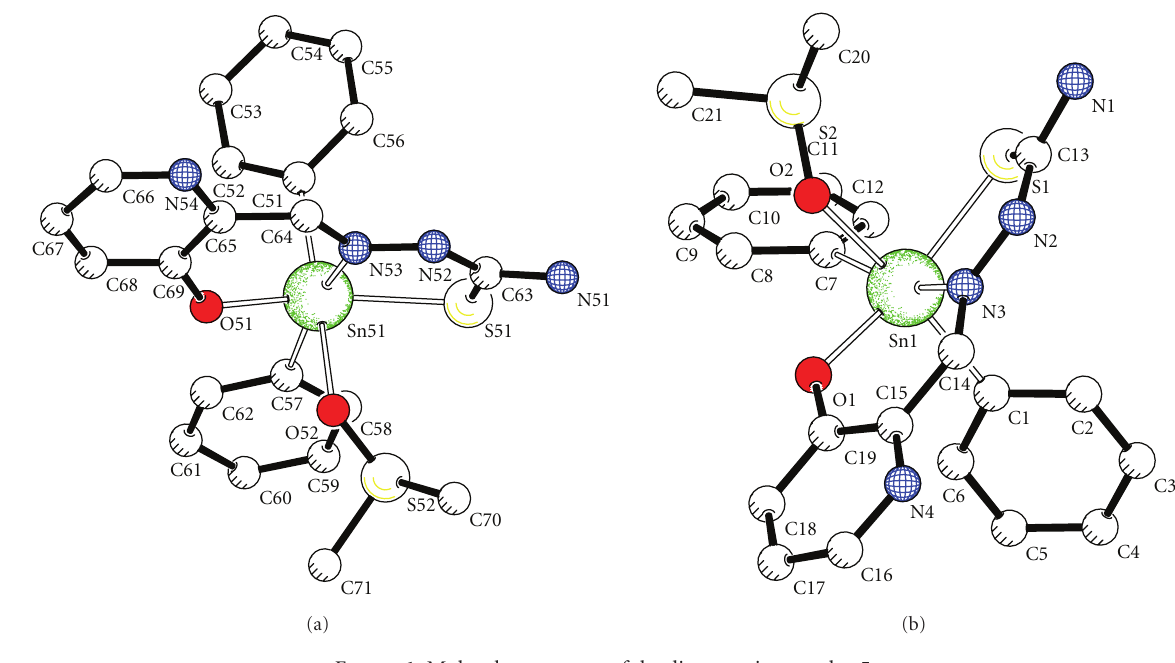
Figure 1: Molecular structure of the diorganotin complex 5 .